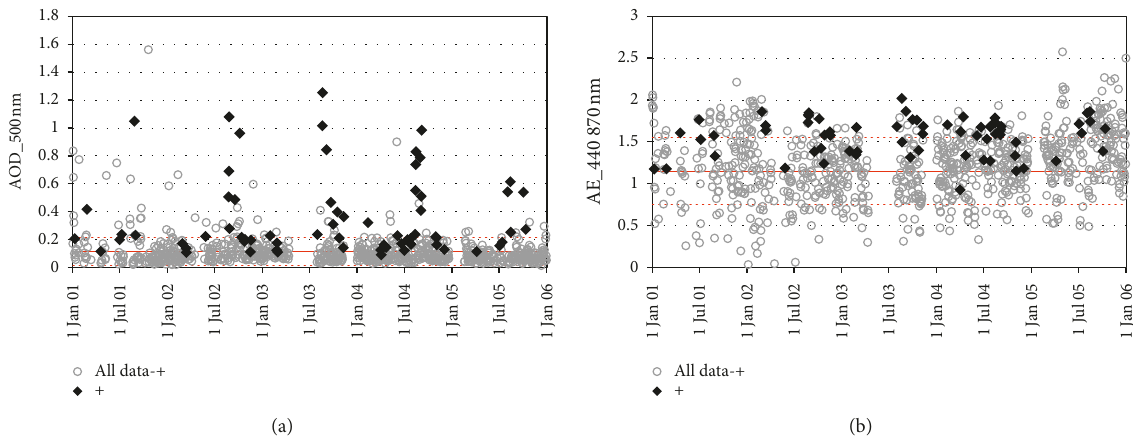
Figure 3: Temporal evolution of daily AOD500nm (a) and ˚Angstr¨om exponent (b) at CEILAP-BA in the five-year period 2001–2005. Black diamond: days with regional transport of biomass-burning aerosols (selected dates). Open circle: daily data with the selected days excluded. + denotes the “selected dates.” The climatological means and standard deviations are included (red